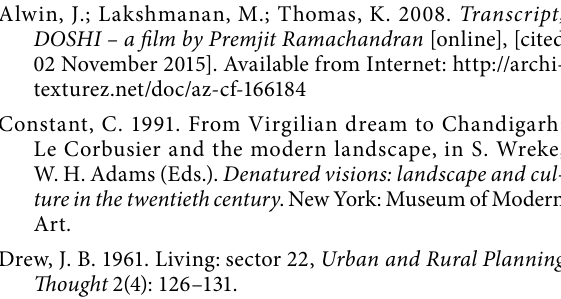
fig. 3. Hussain Doshi Gufa in